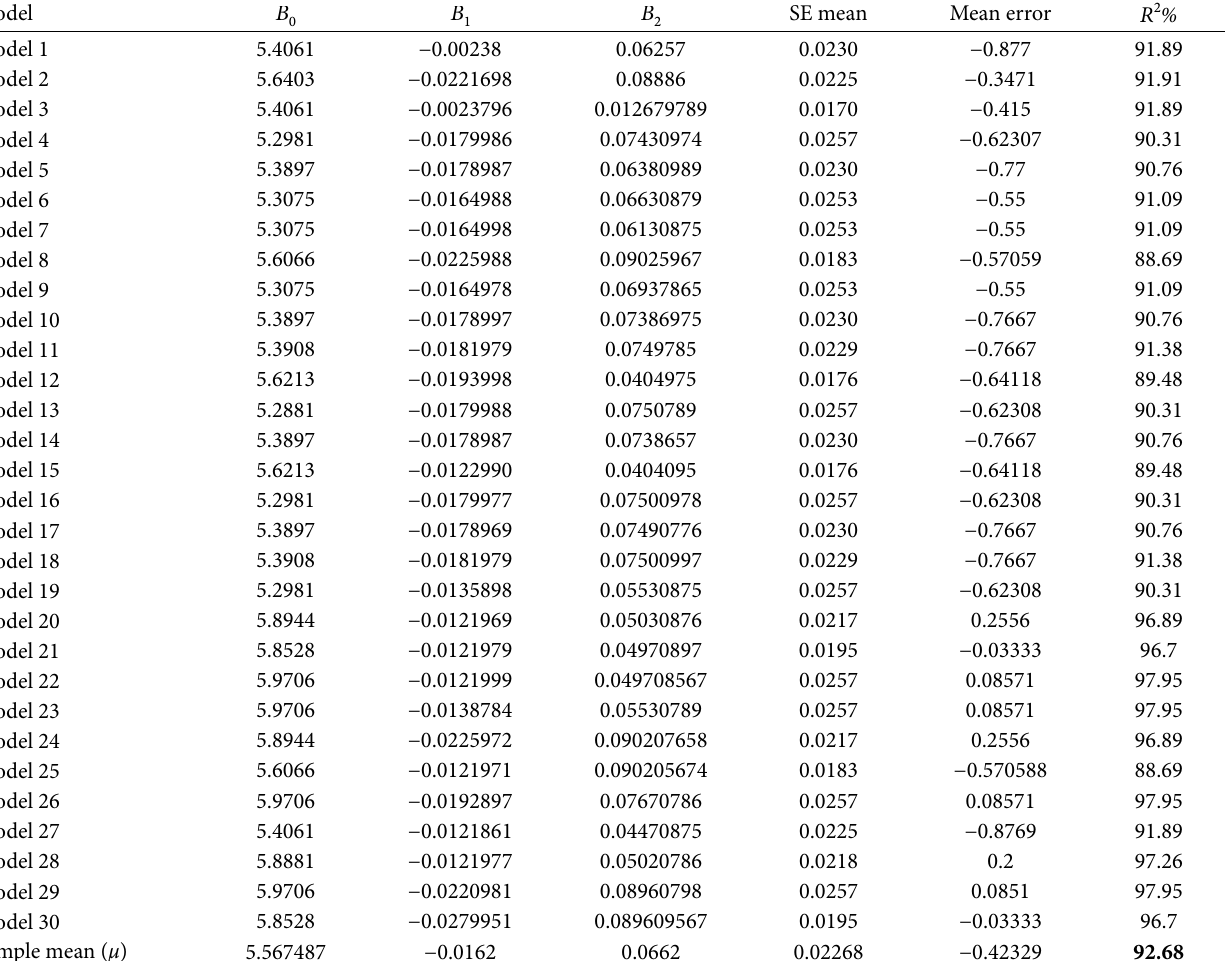
Table 5: The coefficients of the 30 generated models together with their corresponding mean and SE mean of prediction errors.